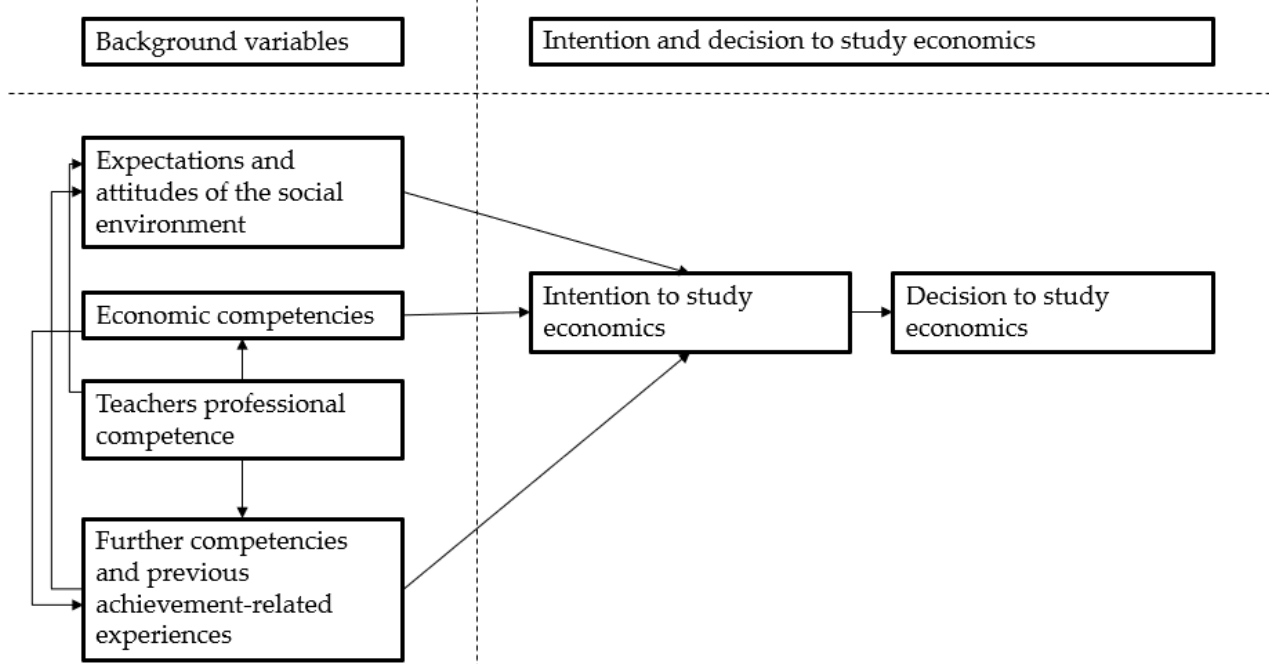
Figure 1. Adjusted and Simplified Expectancy–Value Model Following Eccles and Wigfield (2002).